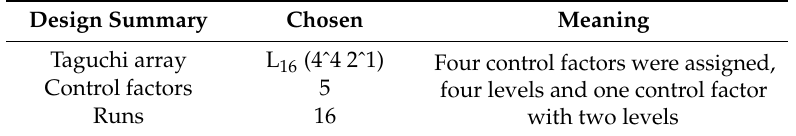
Table 1. Design of the Taguchi orthogonal array.